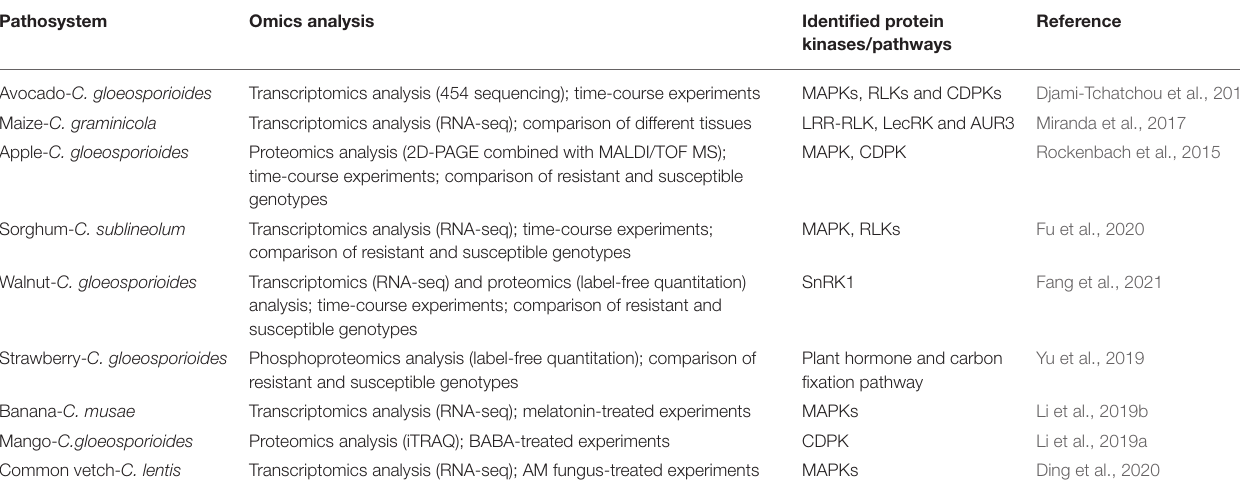
TABLE 2 | Summary of omics analyses in plant- Colletotrichum